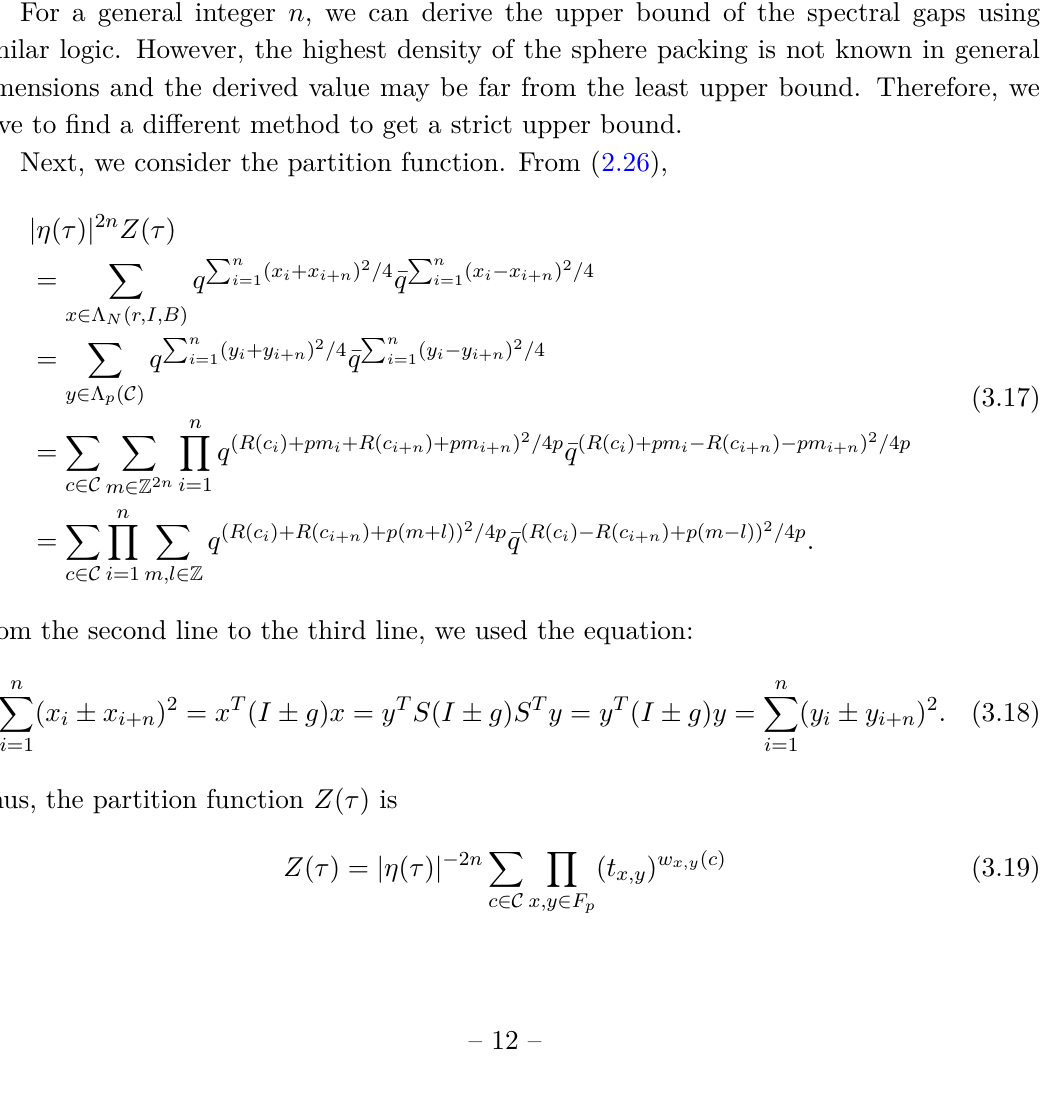
Figure 2. A lattice Λ p =5 ( C 0 ) for a code C 0 ⊂ F 2 centered at points in the